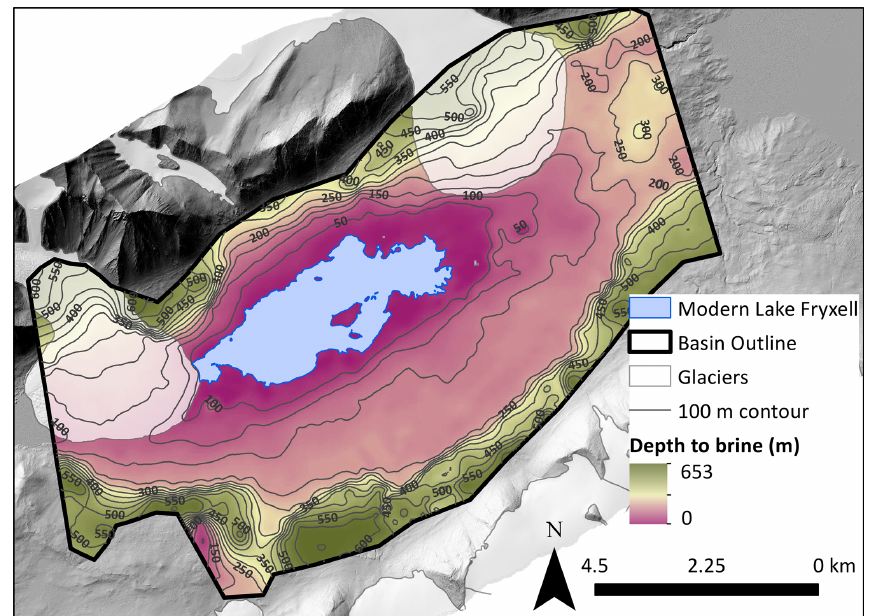
Figure 8. Map showing depth to 100 (cid:127) m brine–permafrost boundary generated from SkyTEM data. Interpolation was smoothed using a low-pass filter in ArcGIS to reduce edge noise. Edges (higher elevations and deeper brine layers) are less reliable because of inversion interpolation artifacts and limitations of depth of investigation. The thick black polygon (basin outline) represents the extent of reliable data, which was truncated at the edge of each flight line to reduce extrapolation artifacts. DEM (1m resolution) is from a 2014–15 lidar survey, accessed via OpenTopography (Fountain et al., 2017).